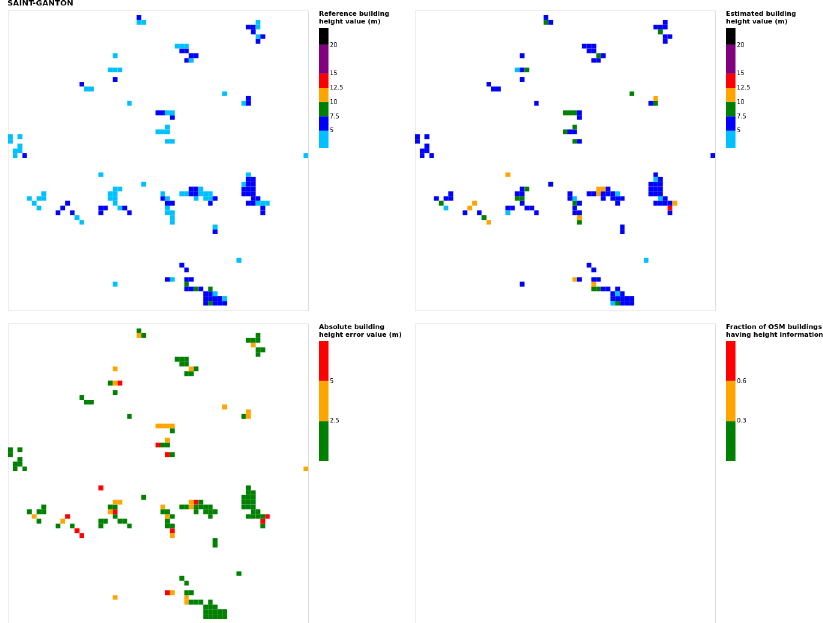
Figure B20. Results for the commune at grid cell (upper left panel) reference building height, (upper right panel) estimated building height, (lower left panel) absolute building height error, and (lower right panel) fraction of OSM buildings that have height information. For all panels except the lower right, only cells that have buildings – with at least 90% of their buildings having no height value in OSM – are